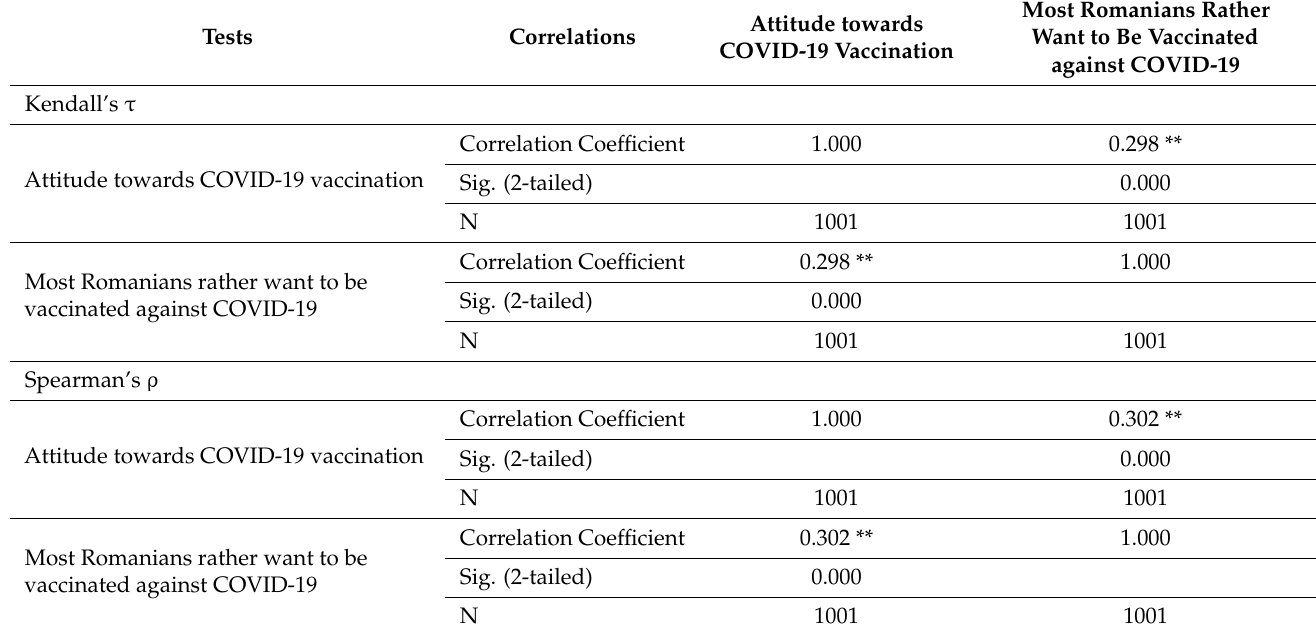
Table 7. Kendall τ and Spearman ρ results for hypothesis